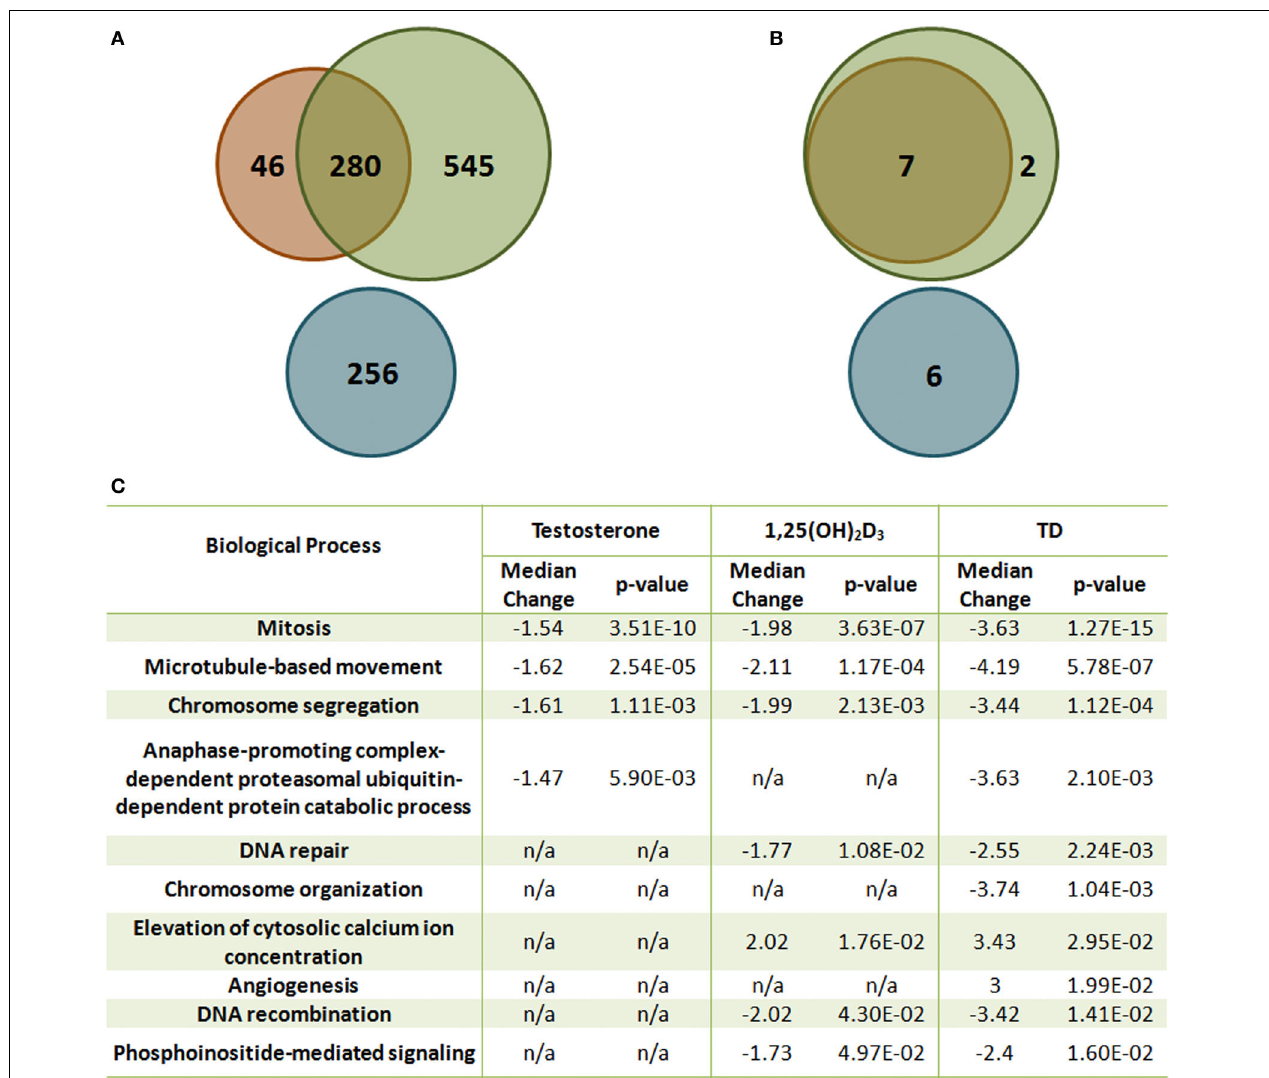
FIGURE 2 | The effect of T and 1,25(OH) 2 D 3 on mRNA and miRNA expression in LNCaP cells. (A) Venn diagram analysis of the gene expression microarray data [Green: 1,25(OH) 2 D 3 -moduated, Orange: androgen-modulated, Blue: synergistically modulated genes by androgen and 1,25(OH) 2 D 3 ]. (B) Venn diagram analysis of the miRNA microarray data